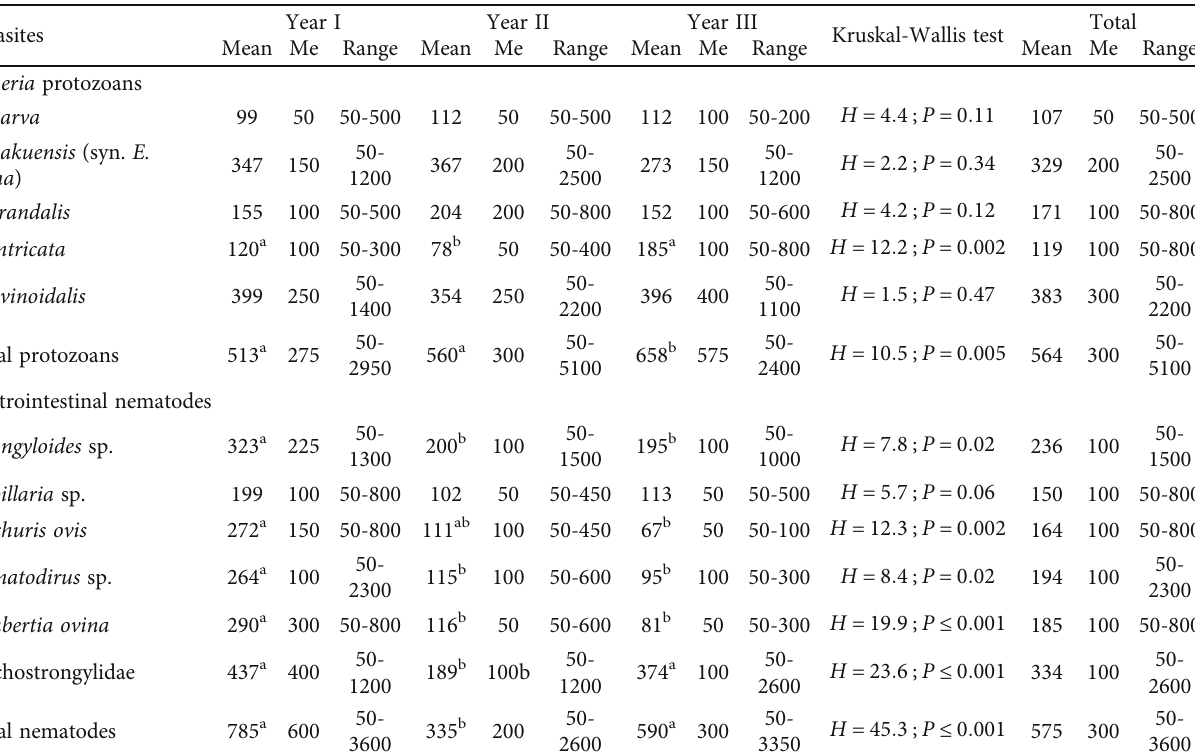
Table 2: Intensity of infection with protozoans (oocysts per gram (OPG)) and gastrointestinal nematodes (eggs per gram (EPG)) in mou fl ons.